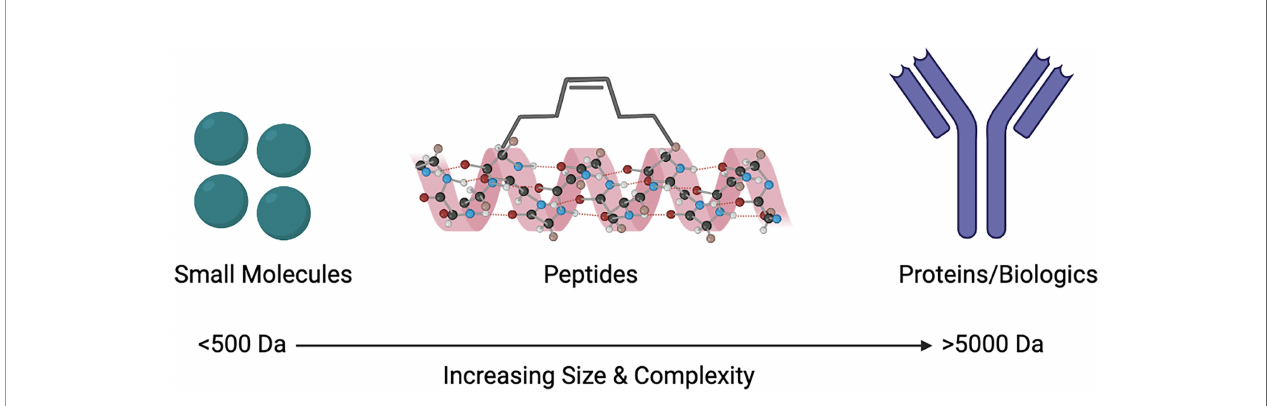
FIGURE 1 | Size comparison of small molecules, peptides and proteins/biologics as therapeutic agents to target protein-protein interactions (PPIs). Created with